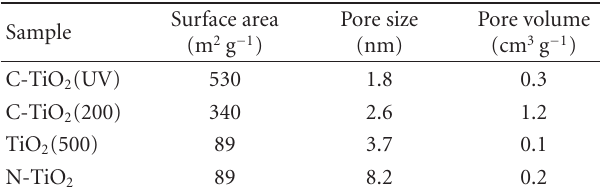
Table 1: Surface area, pore size, and pore volume of the TiO 2